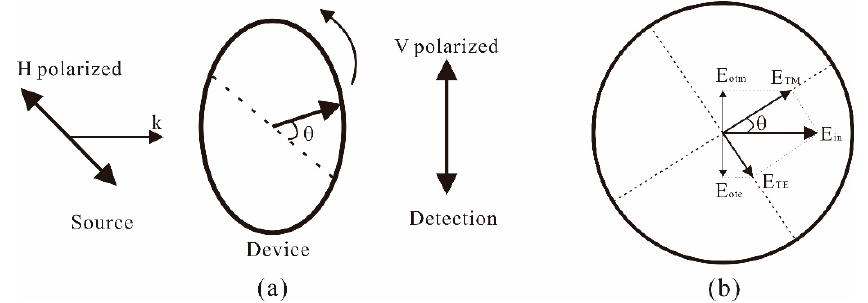
Figure 4. Schematic of measurement of THz anisotropy in the metamaterial.